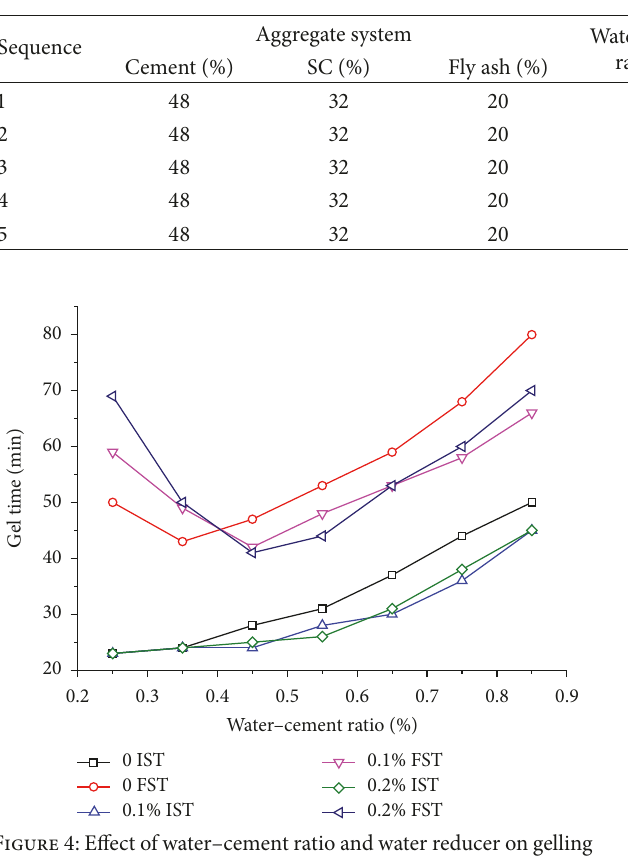
Table 11: Effect of the dosage of foam on the material.